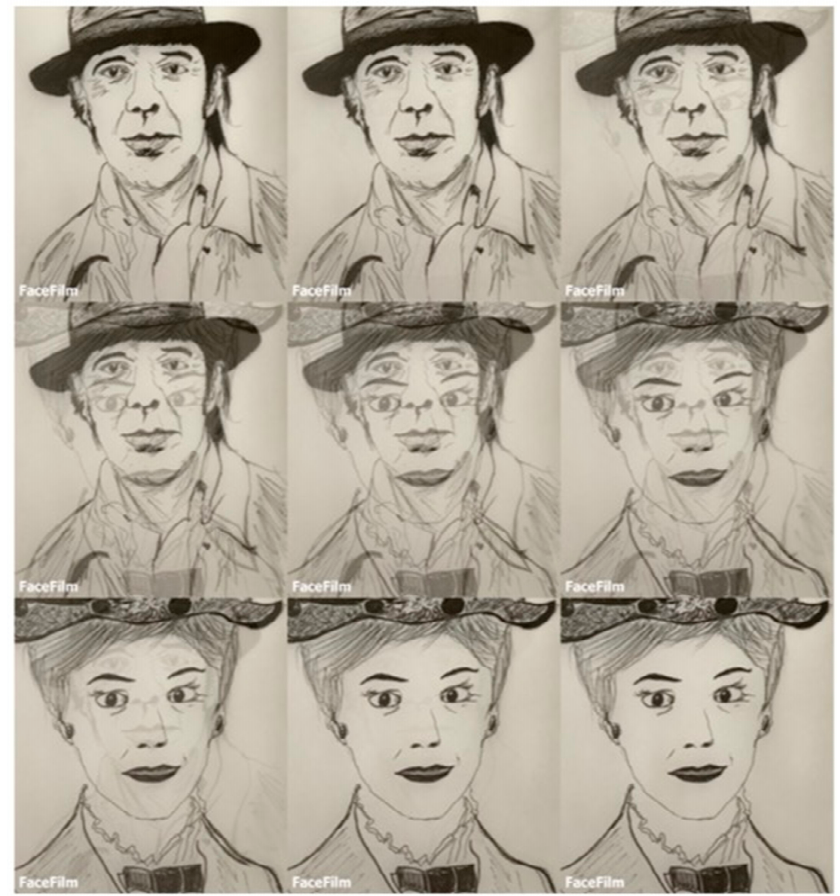
Figure 2. Deleuze becoming Poppins: Polymorphous process of virtual possibilities and dis-identi- fication.